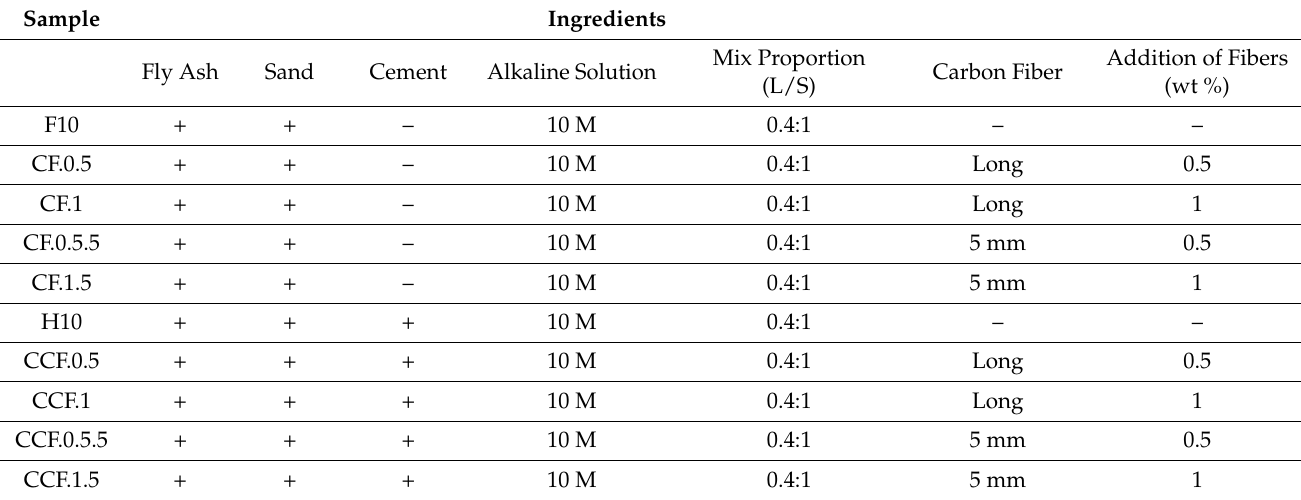
Table 5. Composition of prepared geopolymer composites reinforced with carbon fiber.